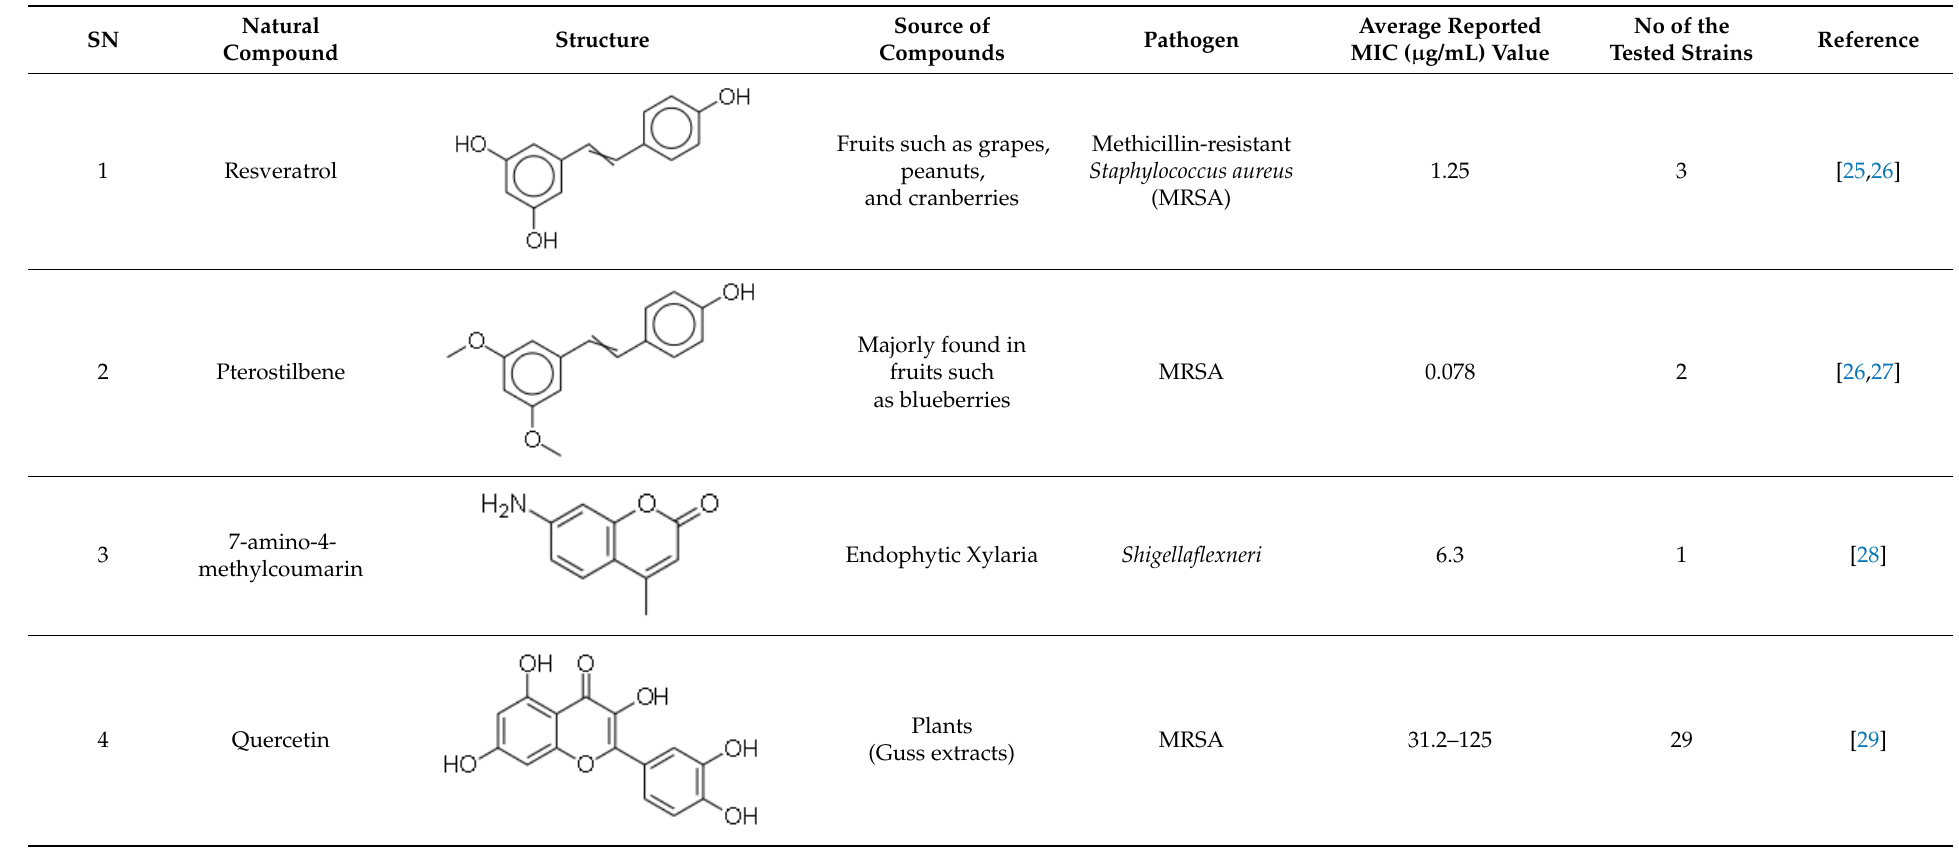
Table 1. Selected natural products with their reported antimicrobial activity.